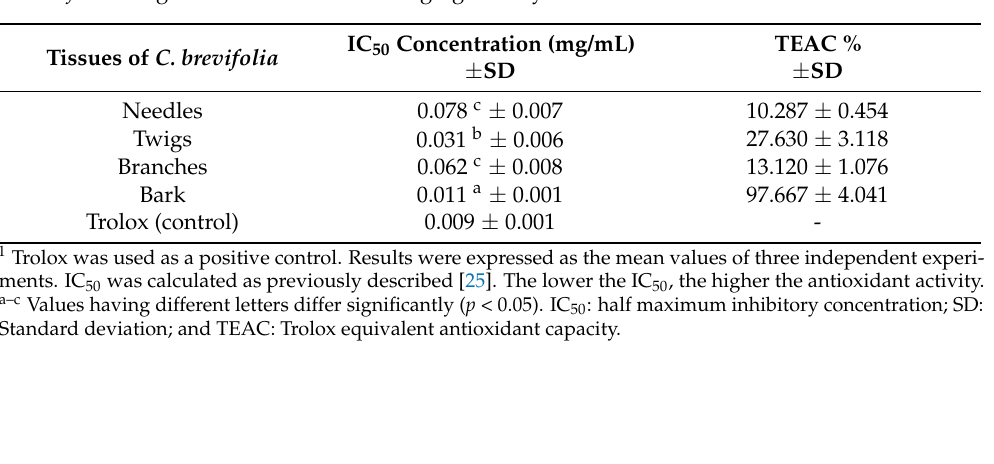
Table 3. Antioxidant activity (IC 50 and TEAC) of methanol extracts from different types of tissue of C. brevifolia using the DPPH radical scavenging activity 1